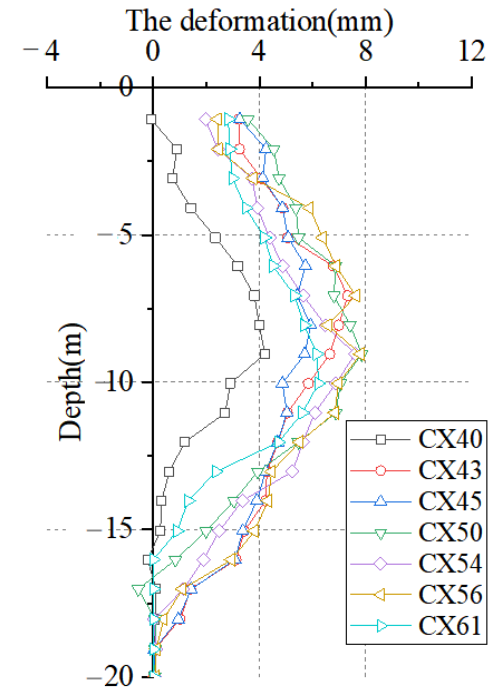
Figure 25. The deep deformation in the central district(CX40–CX61).